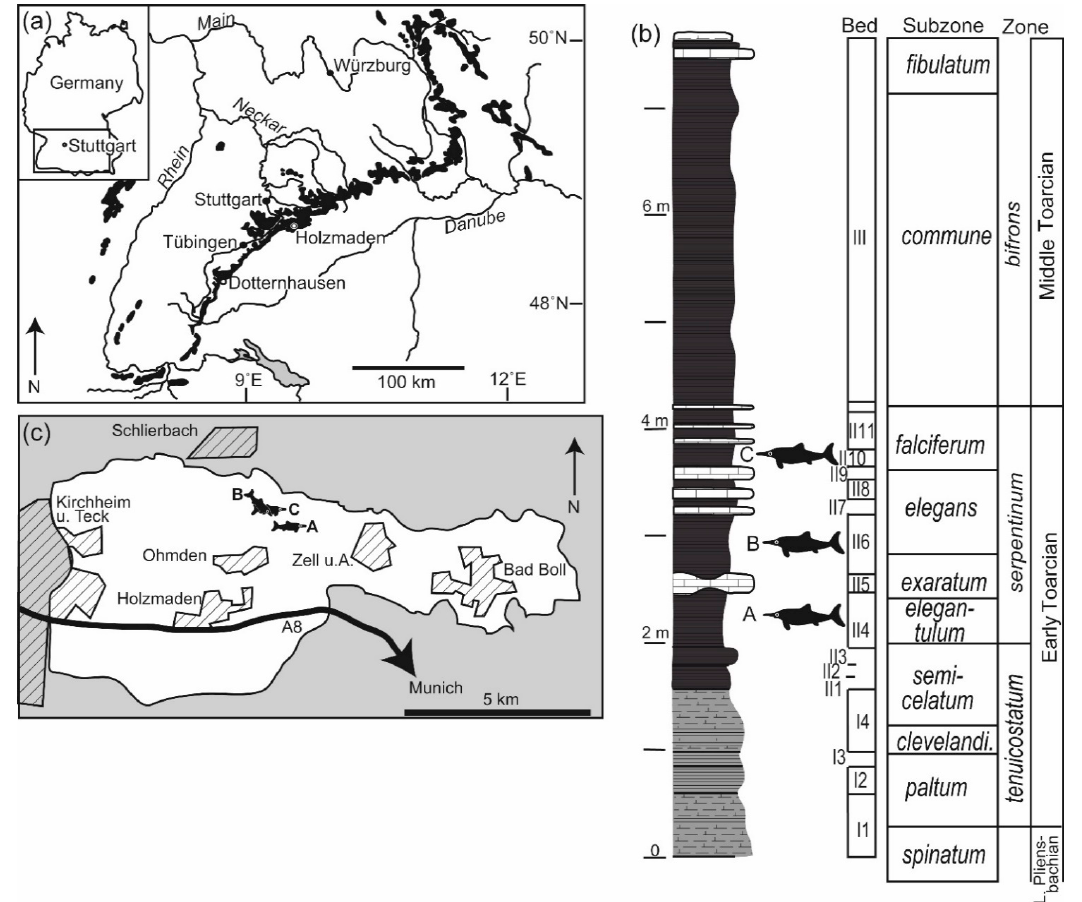
Figure 1. Geographical and geological context. ( a ) Southwestern Germany, with Posidonienschiefer Formation outcrops indicated in black (modified from [33]). ( b ) Stratigraphic column of the Posidonienschiefer Formation at the Holzmaden locality (48°38 ′ 07.2 ″ N 9°31 ′ 36.4 ″ E) indicating the stratigraphic provenance of three of the ichthyosaur deadfall communities discussed in the text. A = SMNS 80234, B = SMNS 81841, and C = SMNS 81719. Stratigraphic column from [34] , ammonite subzones following [35] . ( c ) Map of the Holzmaden paleontological heritage protected area showing the provenance and orientation of the same three skeletons as in part (b).